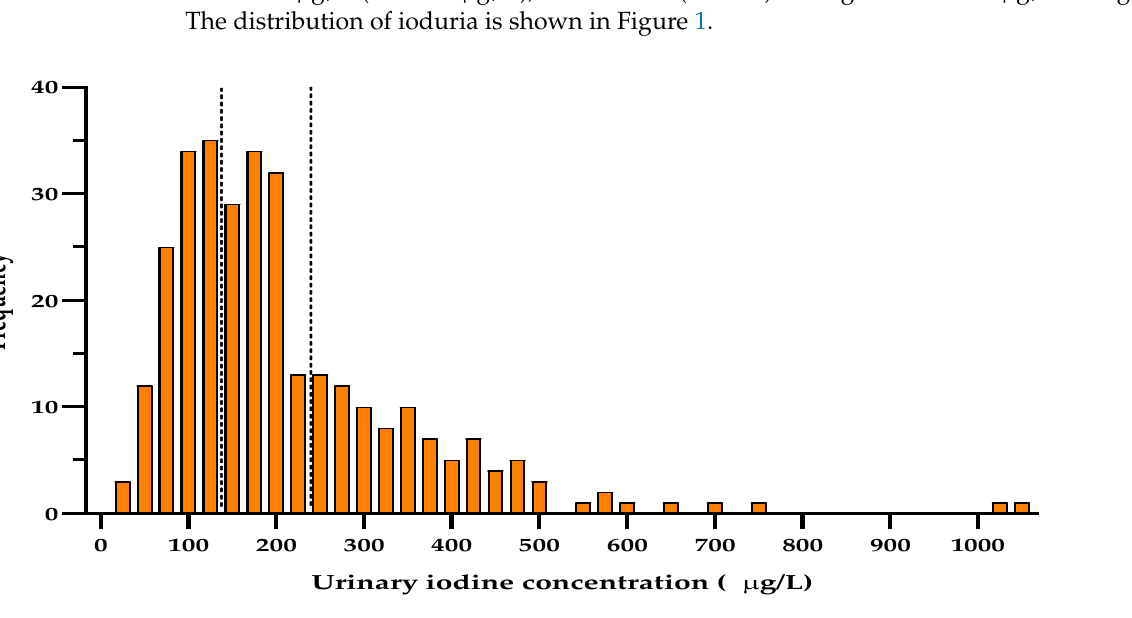
Figure 1. Histogram showing number of woman with different levels of urinary concentration of iodine (μg/L). The dotted lines indicate the recommended range of adequate urinary iodine concentration in pregnant women.